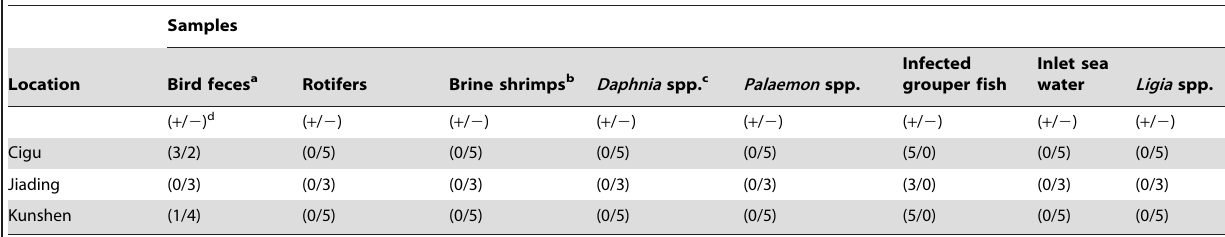
Table 2. Detection of potential nervous necrosis virus (NNV) carriers.